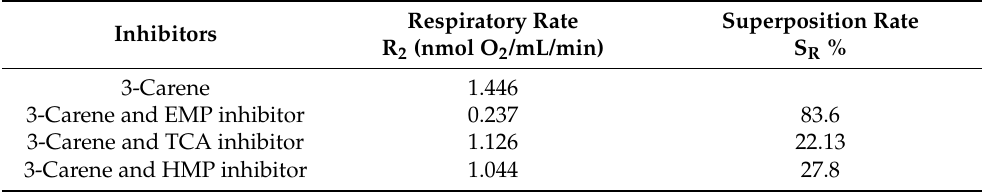
Table 3. The superposition rates between 3-carene and three representative